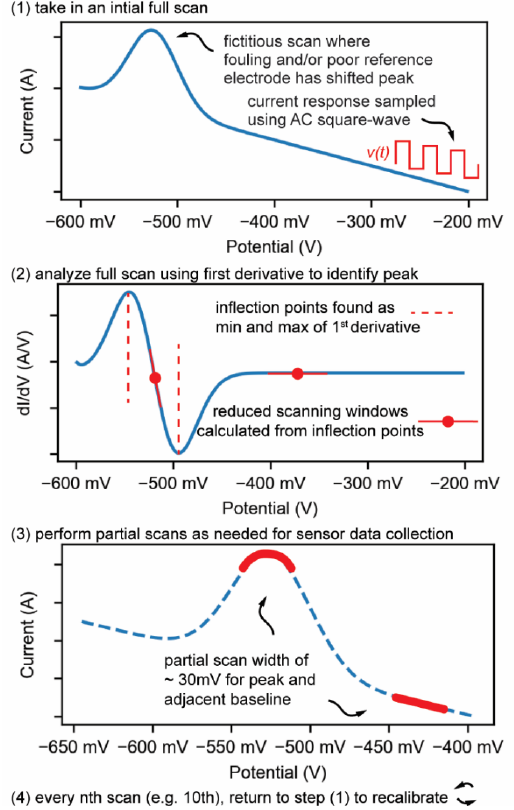
Figure 2. Software process for identifying peaks to generate partial scanning windows. (Step 1) Acquire voltammogram from a full scan that is not centered and is sloped. (Step 2) Take the first derivative in pursuit of the maximum and minimum values (i.e., inflection points). (Step 3) Center voltammogram peak and reduce scanning windows to baseline and peak based on inflection point potentials. (Step 4) Repeat every n scans to maintain centered peak.